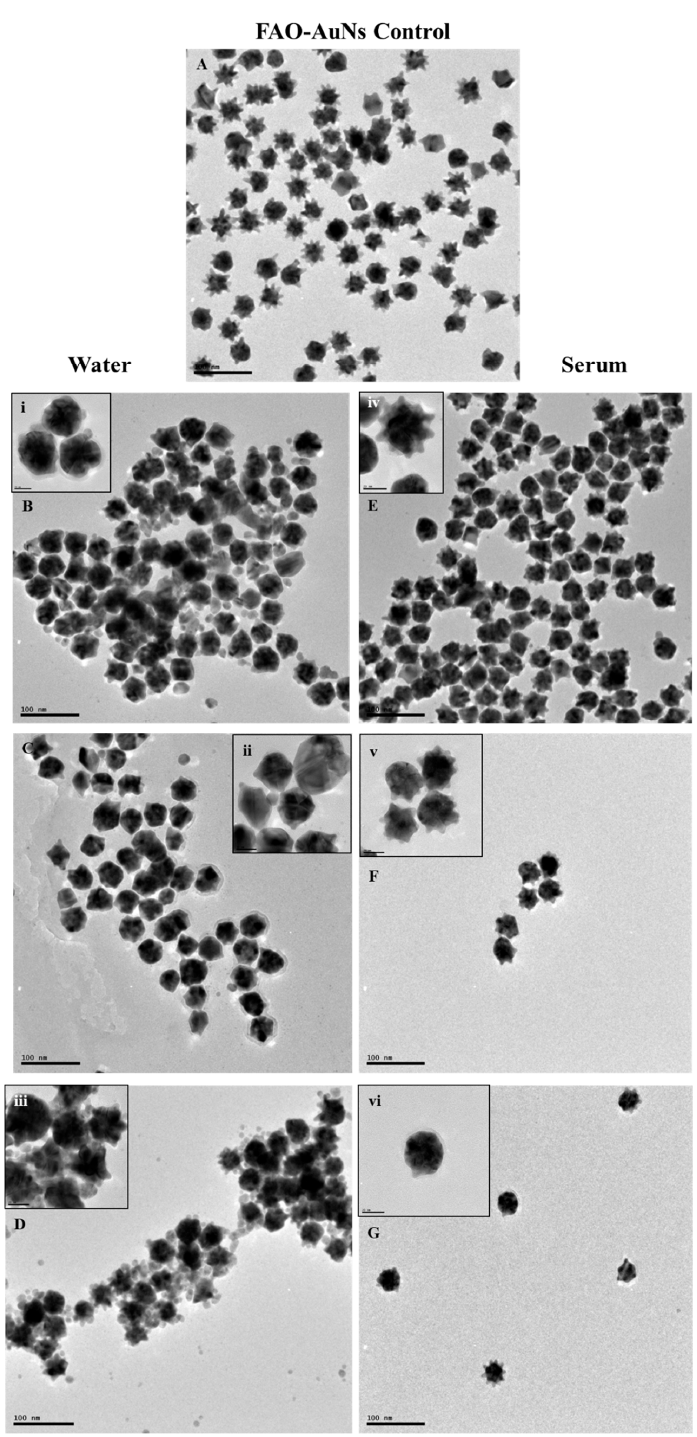
Figure 7. TEM images showing the morphological change of the FAO-AuNs in water and serum for varied fructosyl valine concentrations. ( A ) Is the morphology of FAO-AuNs after functionalisation. In the water environment ( B ) 0 mM, ( C ) 0.018 mM and ( D ) 0.03 mM. In the serum environment ( E ) 0 mM, ( F ) 0.009 mM and ( G ) 0.015 mM respectively. The inserts for each image shows a closer view of the particle morphology.